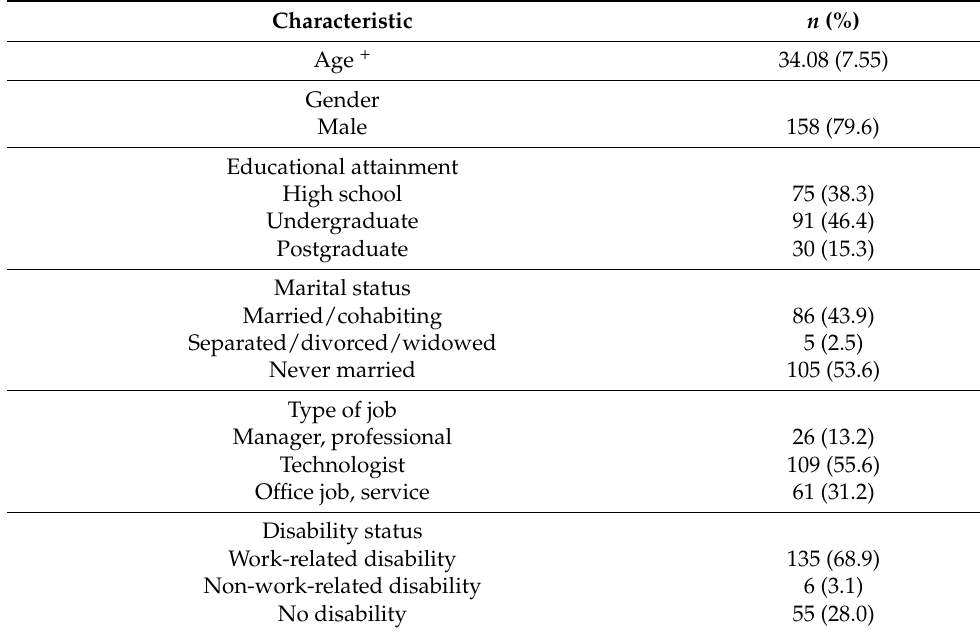
Table 1. Demographic characteristics (N =